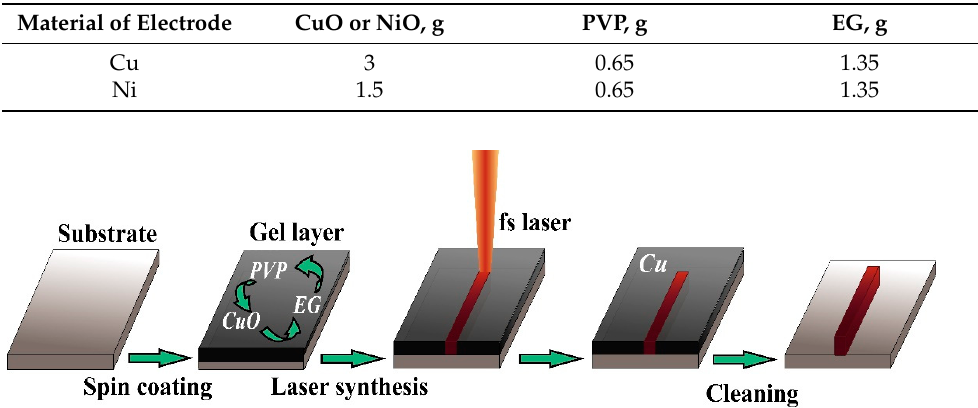
Figure 1. Schematic process of fabrication of metal micropatterns using SLS. A solution containing copper or nickel nanoparticles deposited on a substrate is irradiated with a femtosecond fiber laser (120 fs, Toptica, FemtoFiber pro NIR (780 nm)). The unreacted solution is removed by washing with a solvent. Table 1. The optimized compositions for deposition of Cu and Ni micropatterns on glass-ceramic. Material of Electrode